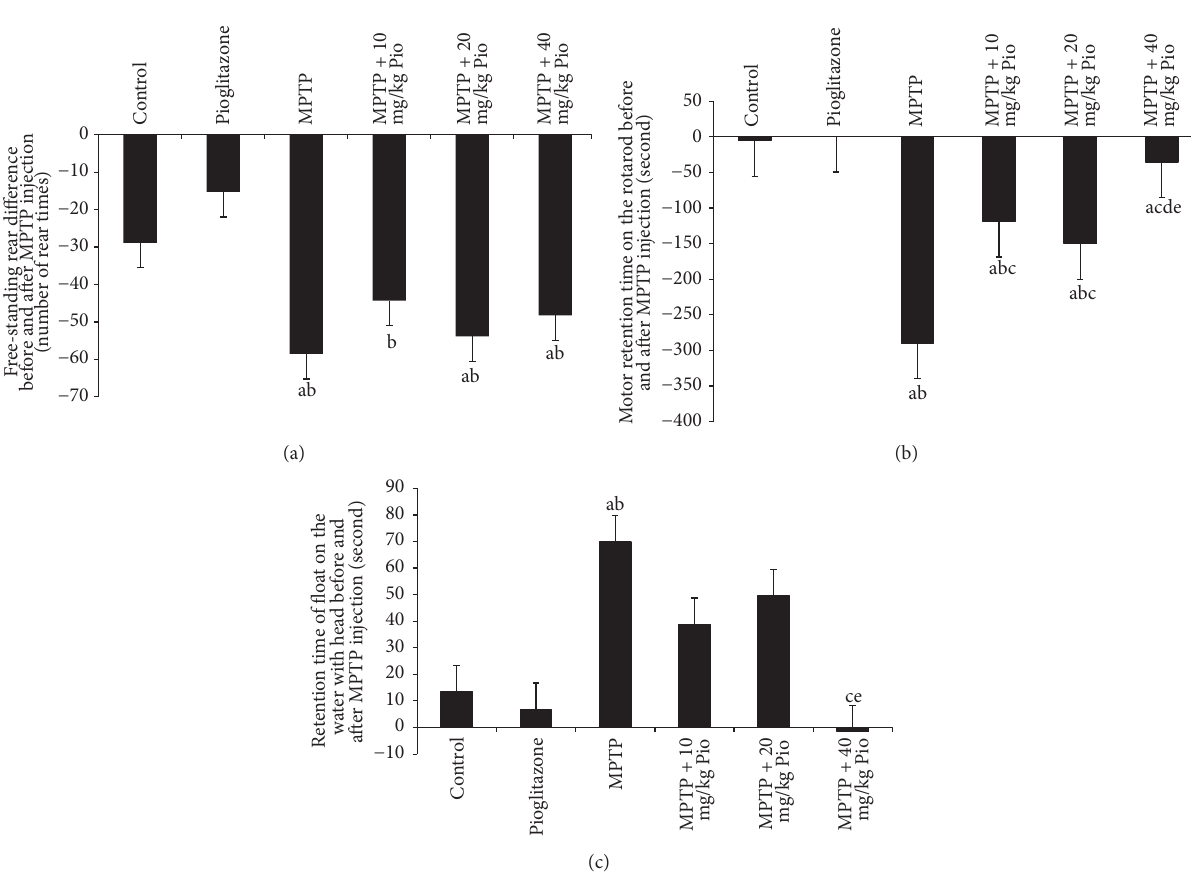
Figure 1: Effect of pioglitazone on behavior in MPTP-treated C57BL/6 mice. “a” indicates 𝑃 < 0.05 , compared with control group; “b” indicates 𝑃 < 0.05 , compared with pioglitazone group; “c” indicates 𝑃 < 0.05 , compared with MPTP group; “e” indicates 𝑃 < 0.05 , compared with MPTP + 20 mg/kg Pio